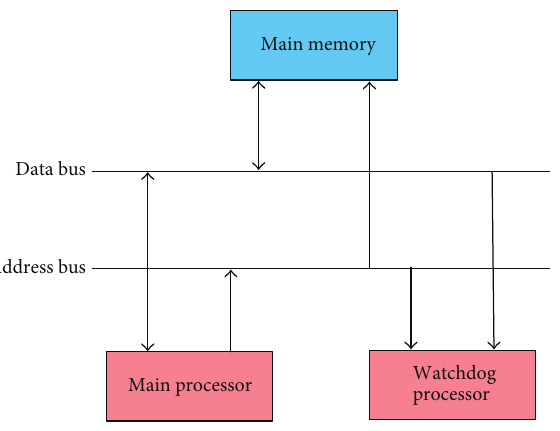
Figure 2: Hardware Control Flow Checking with a Watchdog processor